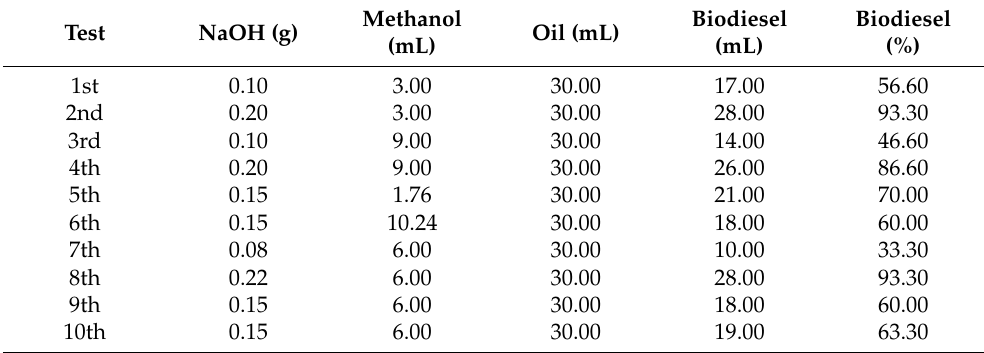
Table 3. Mass-yield values for biodiesel were obtained in different experimental routes.